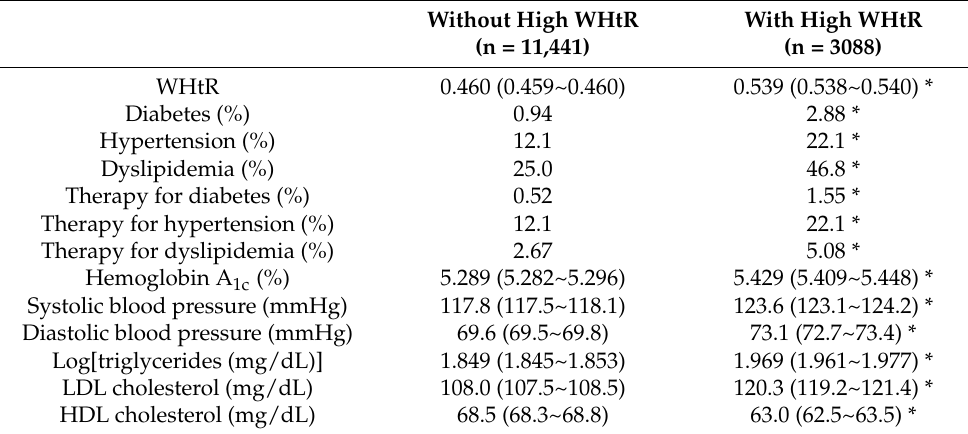
Table 3. Comparisons of cardiometabolic risk factors between subjects without and with a high waist-to-height ratio in the subject group not showing large waist circumference and high BMI in univariable analysis.